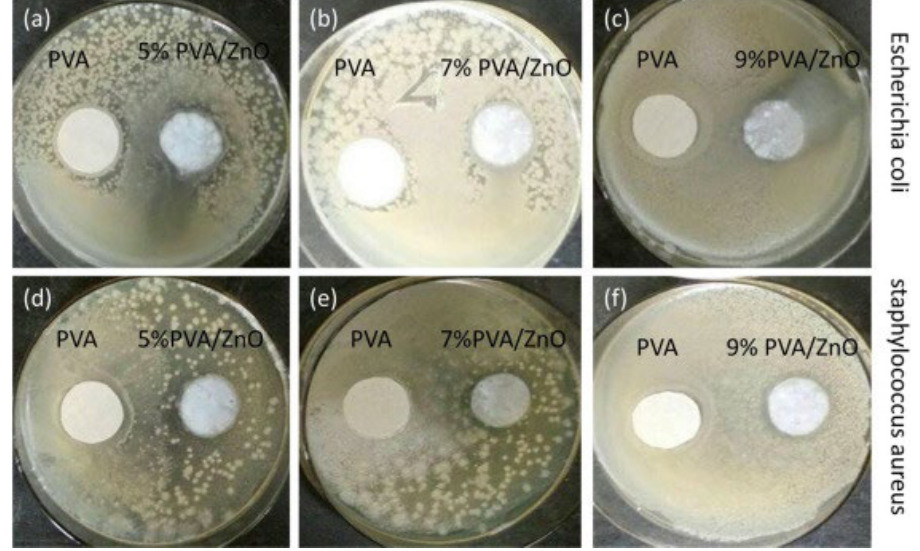
Figure 6. Antibacterial results of PVA nanofibers and PVA/ZnO nanofibers [100].